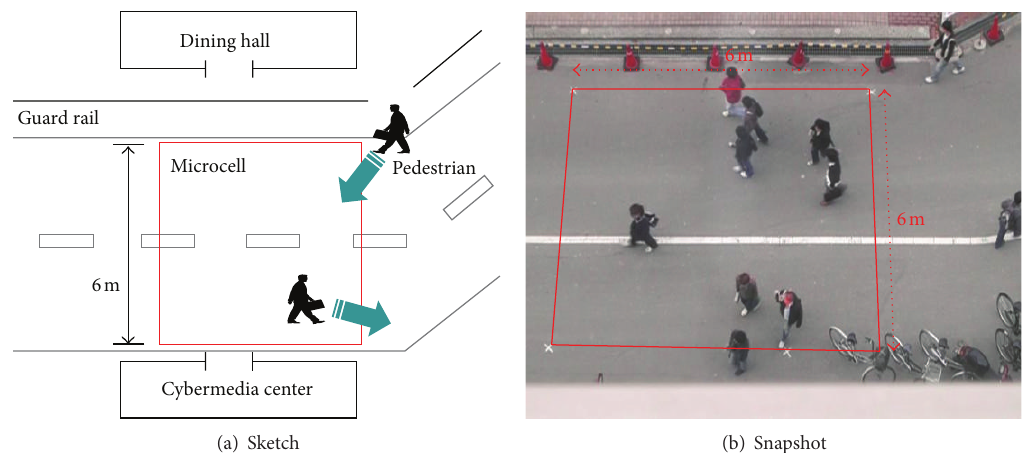
Figure 2: Observation